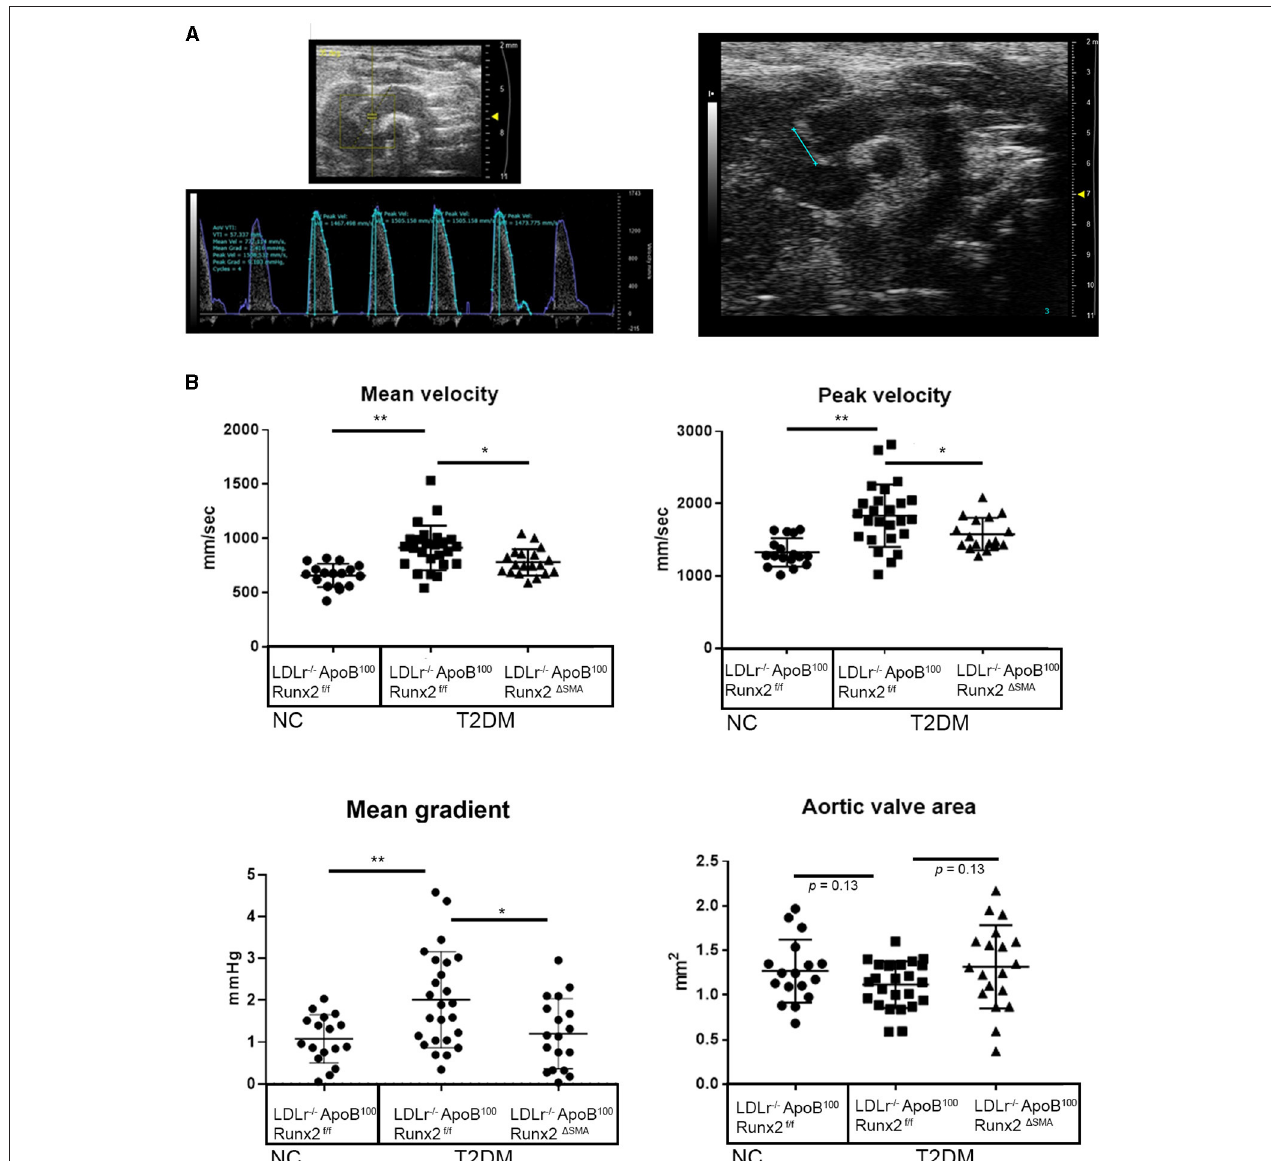
FIGURE 5 | Runx2 depletion in SMA + VICs and sinus walls improves aortic valve function. Representative image of aortic velocity (AoV) flow measurements for blood flow parameters and B mode image used for aortic valve area measurements (A) . (B) Quantitative analysis of the mean velocity, AoV peak velocity, mean gradient, peak gradient, and aortic valve area between the 26 wk LDLr − / − ApoB 100 Runx2 f / f normal chow (NC, n = 18), T2DM diet LDLr − / − ApoB 100 Runx2 f / f ( n = 25),